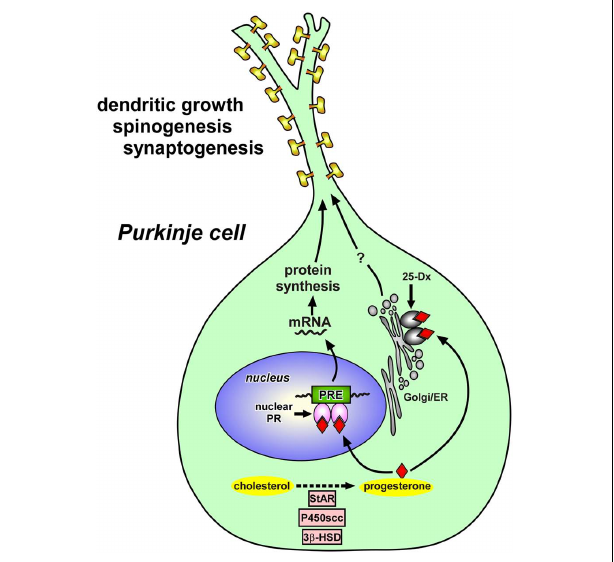
FIGURE 2 | Schematic model depicting possible actions of progesterone in the Purkinje cell during development. Progesterone acts on the Purkinje cell through intranuclear receptor (PR)-mediated mechanisms that promote dendritic growth, spinogenesis, and synaptogenesis in this neuron by genomic mechanisms.Thus, progesterone produced in the Purkinje cell may mediate its actions through an “ intracrine ” mechanism. Progesterone may induce the expression of some neurotrophic factors that directly promote Purkinje dendritic growth, spinogenesis, and synaptogenesis during neonatal life. Progesterone may also act on Purkinje cells through the mechanisms mediated by 25-Dx, which is associated with membrane structures of the endoplasmic reticulum and Golgi apparatus. See the text for details. StAR, steroidogenic acute regulatory protein; P450scc, cytochrome P450 side-chain cleavage enzyme; 3 β -HSD, 3 β -hydroxysteroid dehydrogenase/ Δ 5 - Δ 4 -isomerase; PR, progesterone receptor; PRE, progesterone response element; Golgi, Golgi apparatus; ER, endoplasmic